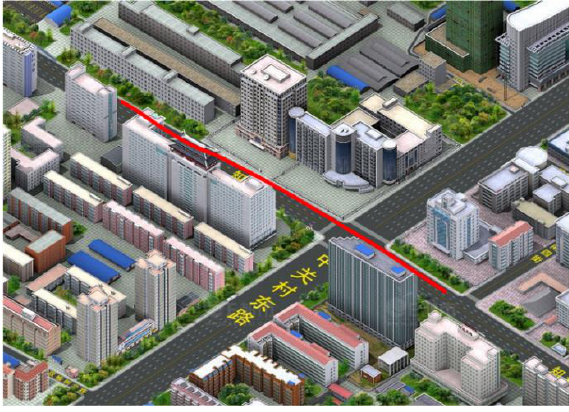
Figure 14. 3D map of the unblocked road.